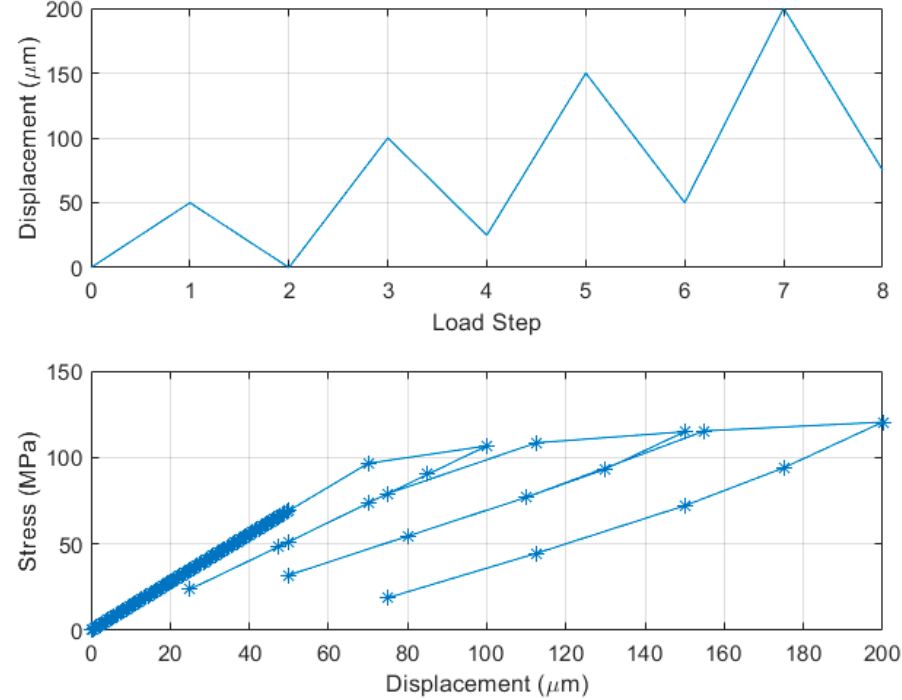
Figure 12. Tensile test of the PSPI model with cyclic loading; loading condition ( top ) stress-displacement curve ( bottom ).